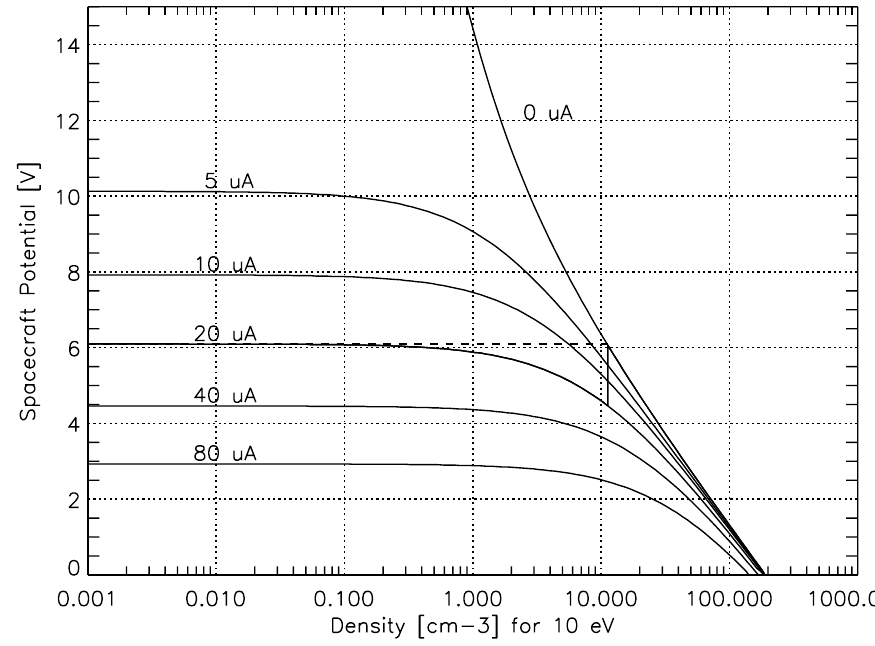
Fig. 5. Spacecraft potential control in constant current mode at 20 µ A (bold line) and in feedback mode (dashed